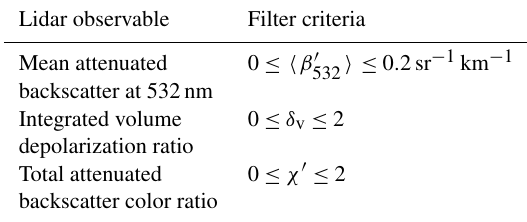
Table 1. Filter thresholds for FKM lidar observables. Lidar